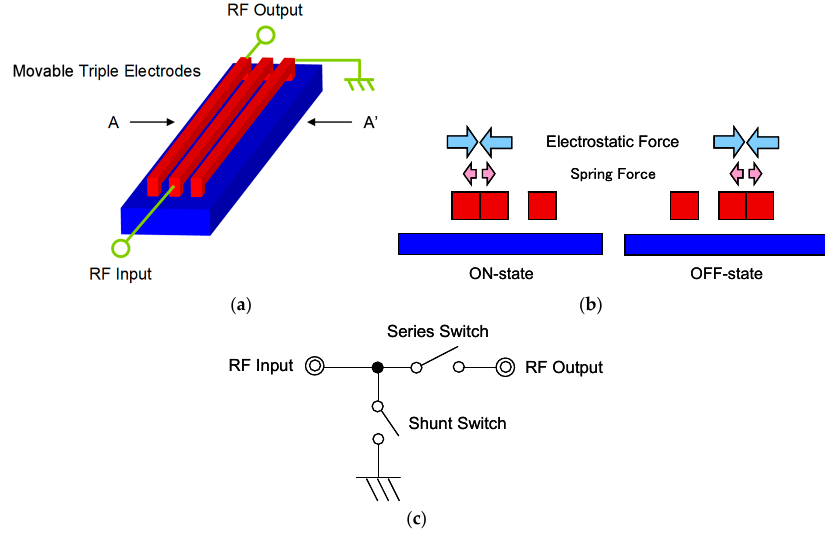
Figure 1. Schematic diagram of the radio frequency micro-electro-mechanical systems (RF-MEMS) switch using laterally movable triple electrodes actuator: ( a ) overview; ( b ) cross-sectional view along A–A’; and ( c ) equivalent circuit.